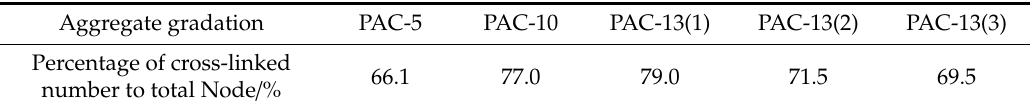
Table 5. Cross-linked number